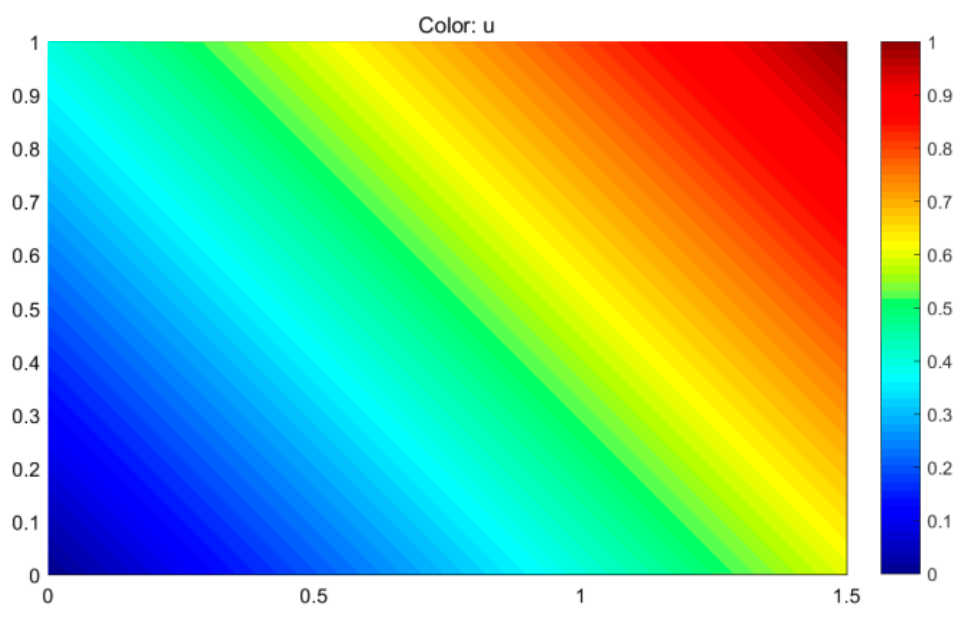
Figure 3. The potential distribution of the rectangular homogeneous conductive plane with the boundary potential distribution of linear increase.